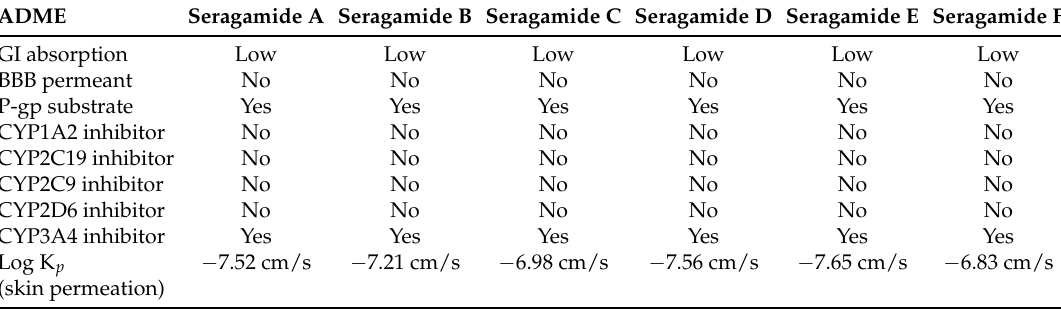
Table 6. ADME parameters related to pharmacokinetics of Seragamides